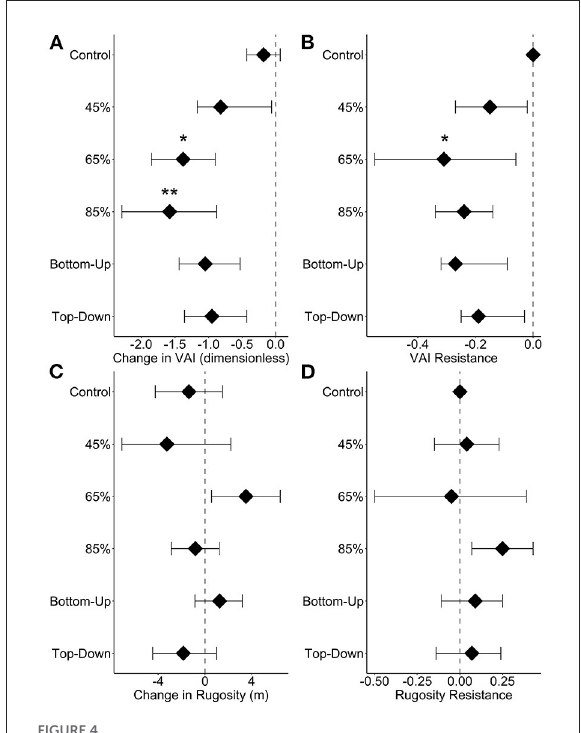
FIGURE4 Comparisons of mean vegetation area index (VAI) from 2018 to 2021 (A) and VAI resistance (the log ratio of experimental VAI resistance compared to control VAI resistance) (B) . Then, comparisons of mean canopy rugosity from 2018 to 2021 (C) and rugosity resistance (the log ratio of experimental rugosity resistance compared to control rugosity resistance) (D) . Bars represent 95% confidence intervals. Significant differences from the control plots are indicated by a single star ( p < 0.05) or two stars ( p < 0.01) (A, C) . Vertical lines at 0.0 indicate no change over time in panels A and C ; vertical lines at 0.0 indicate resistance values equal to the control in panels B and D